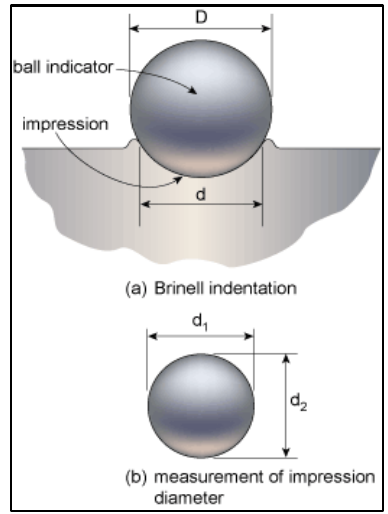
Figure 2: Sample of Brinell hardness Test [10].